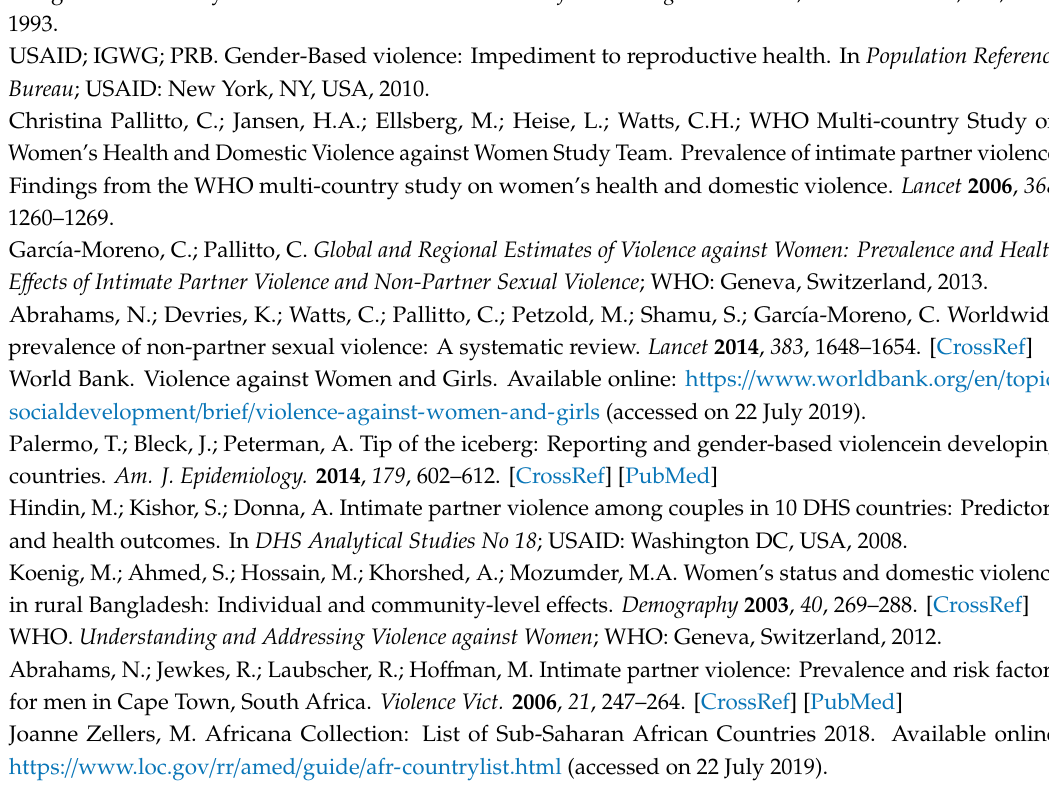
Figure S1: PRISMA flow chart for selection of studies on prevalence of GBV; Figure S2: overall pooled prevalence of IPV; Figure S3: pooled prevalence of physical or sexual violence committed by husband / partner among ever-married women age 15-49 years of old using latest DHS surveys; Figure S4: past one year pooled prevalence of IPV; Figure S5: pooled prevalence of physical IPV; Figure S6: pooled prevalence of sexual IPV by timing; Figure S7: overall pooled prevalence and recent past year prevalence of emotional IPV; and Figure S8: pooled prevalence of non-IPV. In addition, Table S1: search strategy, and Table S2: quality assessment of included